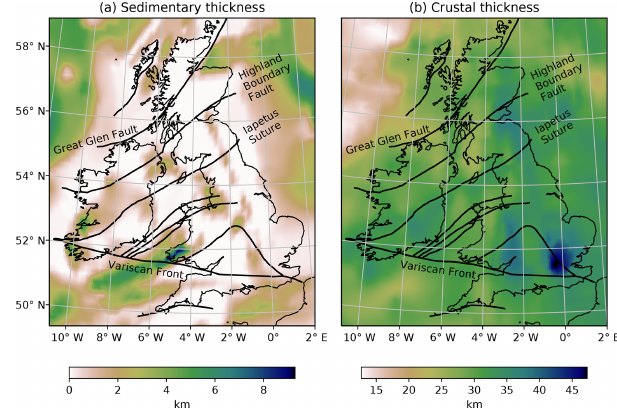
Figure 8. Maps of layer geometries extracted from the model of Baykiev et al. (2018), overlain with major tectonic structures. (a) Sedimentary thickness and (b) crustal thickness variations across the British Isles. The Iapetus Suture marks the boundary be- tween Laurentia and